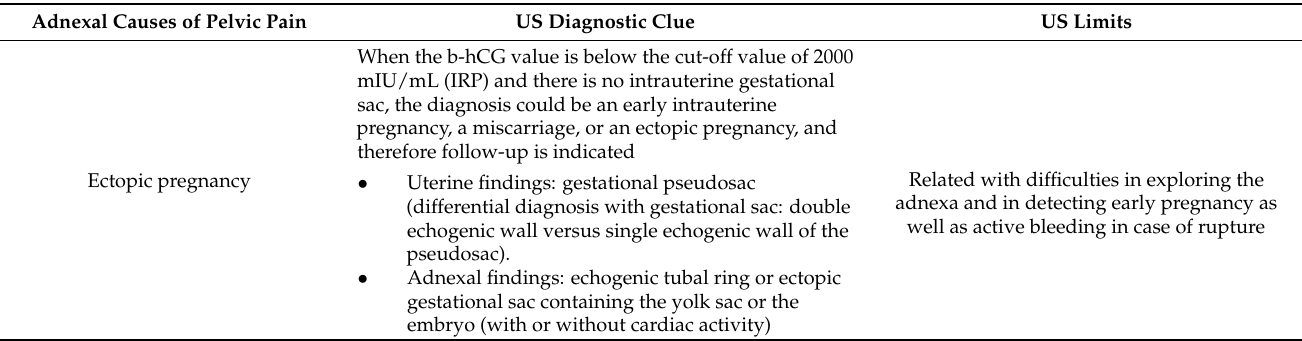
Figure 12. Ectopic pregnancy. Axial ( a ) and longitudinal ( b ) TSA–US scans reveal an extrauterine adnexal gestational sac with a fetal body (( a , b ), arrow). On pulsed Doppler ( c ) a heartbeat is also detected. Table 9. Ectopic pregnancy US diagnostic